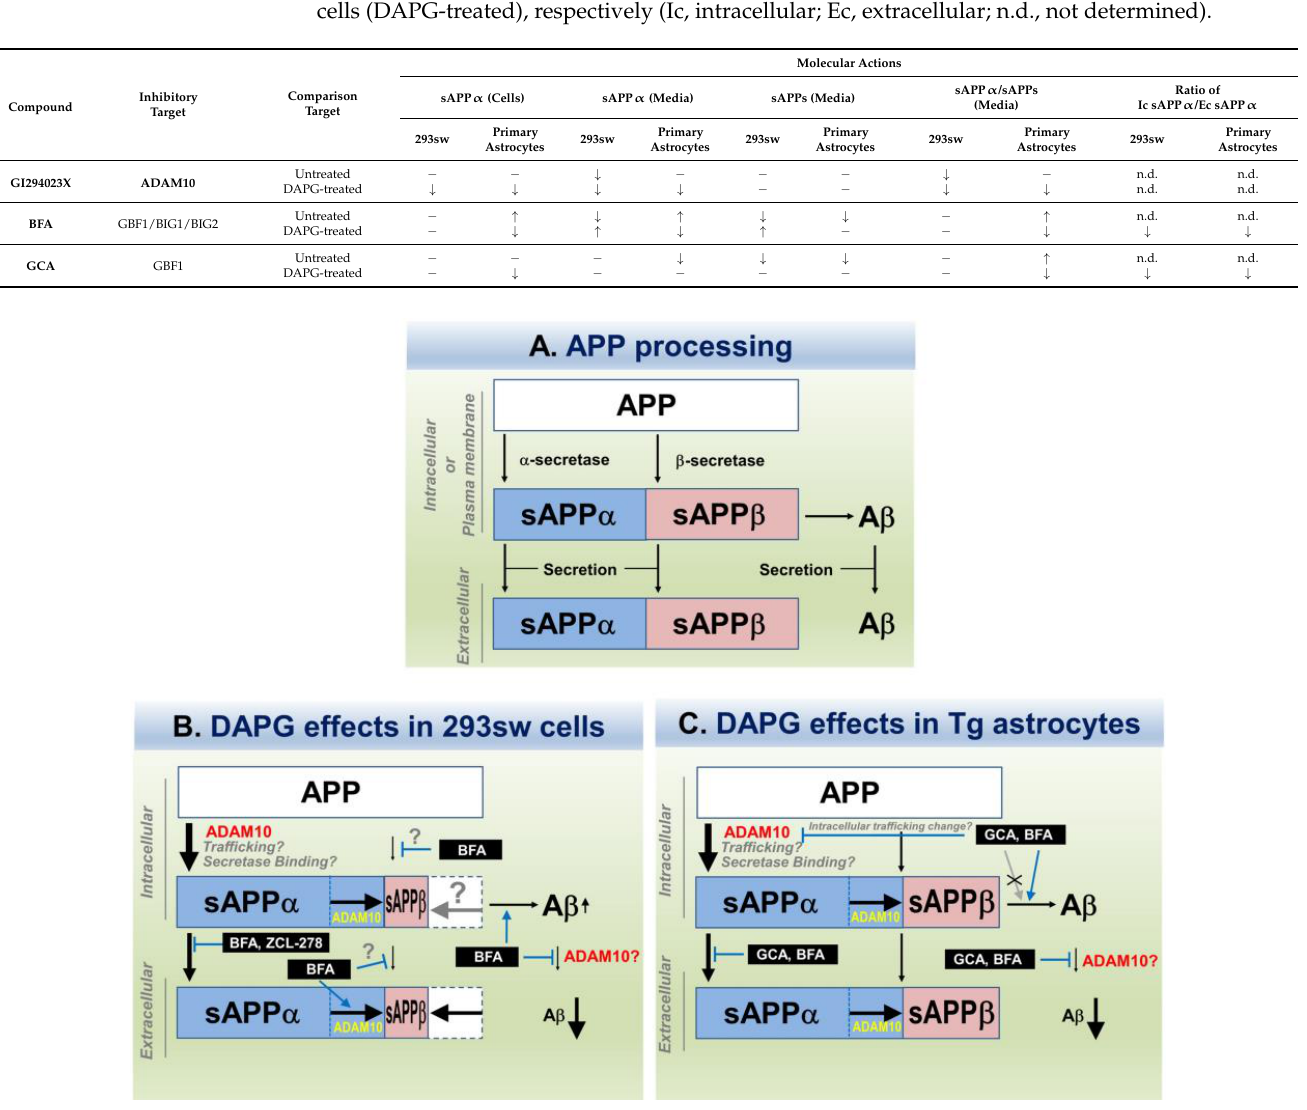
Figure 11. Schematic illustration of the mechanisms activated by DAPG to decrease Aβ levels and increase sAPPα levels in 293sw cells and primary astrocytes from APPsw/PS1dE9 transgenic mice. ( A ) APP processing pathways leading to Aβ and sAPPα production and secretion. ( B ) Effects of DAPG on Aβ and sAPPα production and secretion in 293sw cells and impact of the trafficking inhibitors BFA and ZCL-278. ( C ) DAPG effects on Aβ and sAPPα production and secretion in primary astrocytes from APPsw/PS1dE9 transgenic mice and impact of the trafficking inhibitors GCA and BFA.